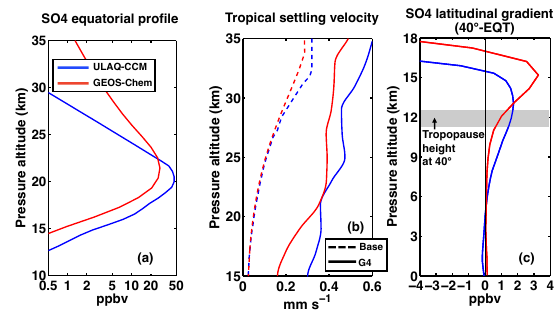
Figure 2. (a) Equatorial SO 4 profiles (ppbv) for ULAQ-CCM (blue) and GEOS-Chem (red), in the G4 experiment (panels a, b of Fig. 1). (b) Tropical settling velocities (mms − 1 ) for the two models (aver- aged 20 ◦ S–20 ◦ N), with dashed and solid lines for Base and G4 experiments, respectively. (c) Latitudinal SO 4 gradient (ppbv), cal- culated in the G4 experiment as the mixing ratio difference between 40 ◦ (40 ◦ S and 40 ◦ N average) and the equator.